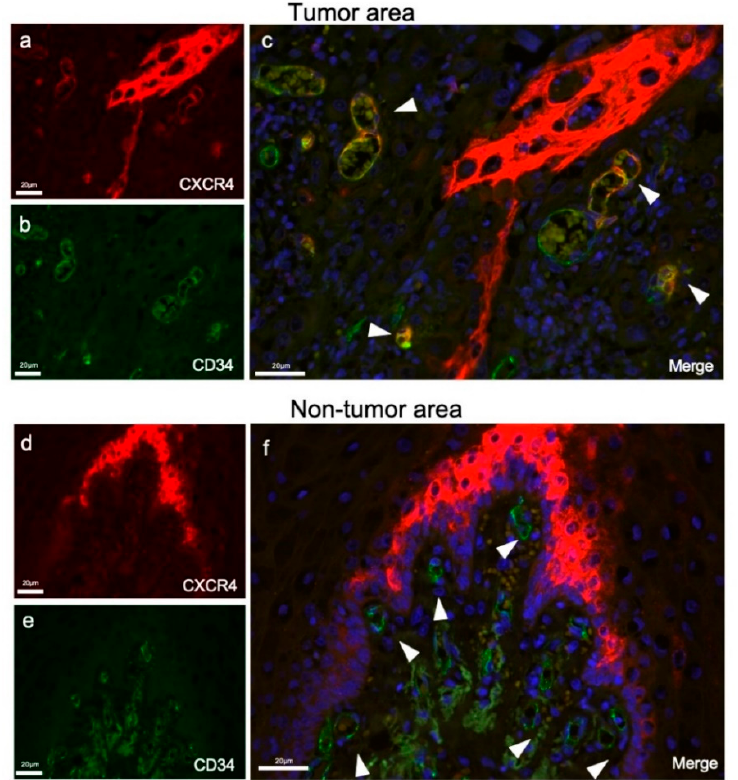
Figure 2. Double-fluorescent IHC for CXCR4 and CD34 in tumor and nontumor areas. ( a ) CXCR4 stained in stromal vessels and tumor cells (red). ( b ) CD34 stained only on vessels in the tumor stroma (green). ( c ) A merged IHC image of CD34 and CXCR4. Nuclei were stained with DAPI. Arrowheads indicate CXCR4/CD34 double-positive tumor vessels in the OSCC stroma. ( d ) CXCR4 stained in the nontumor area (red). ( e ) CD34 stained in the nontumor area (green). ( f ) A merged IHC image of CD34 and CXCR4. Nuclei were stained with DAPI. CD34-positive endothelial cells were all negative for CXCR4